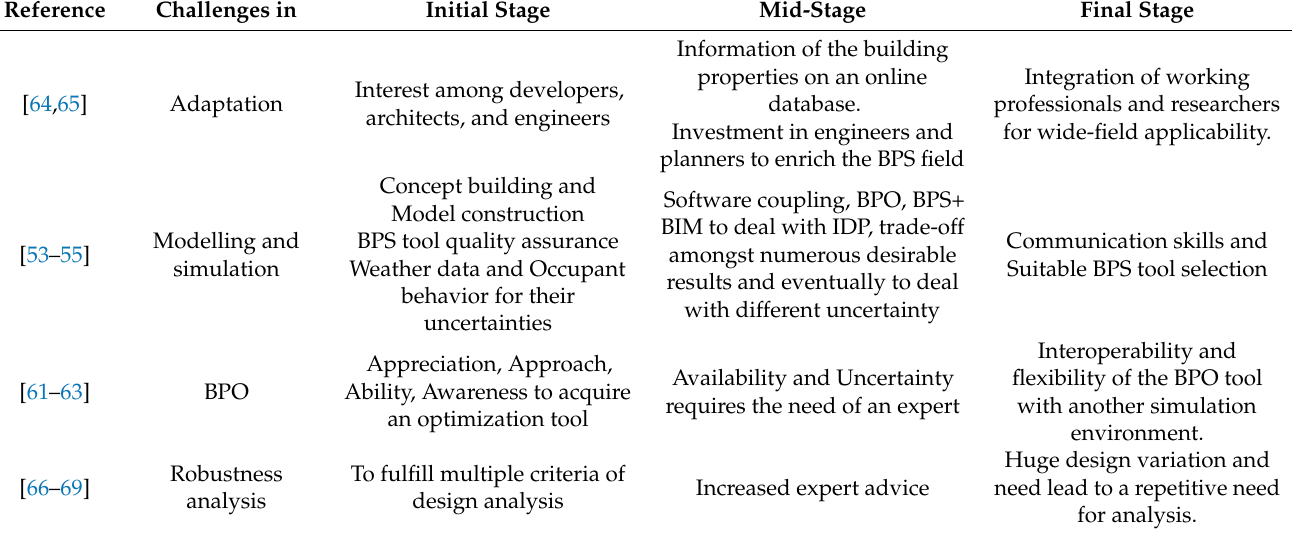
Table 2. Different stages of challenges in